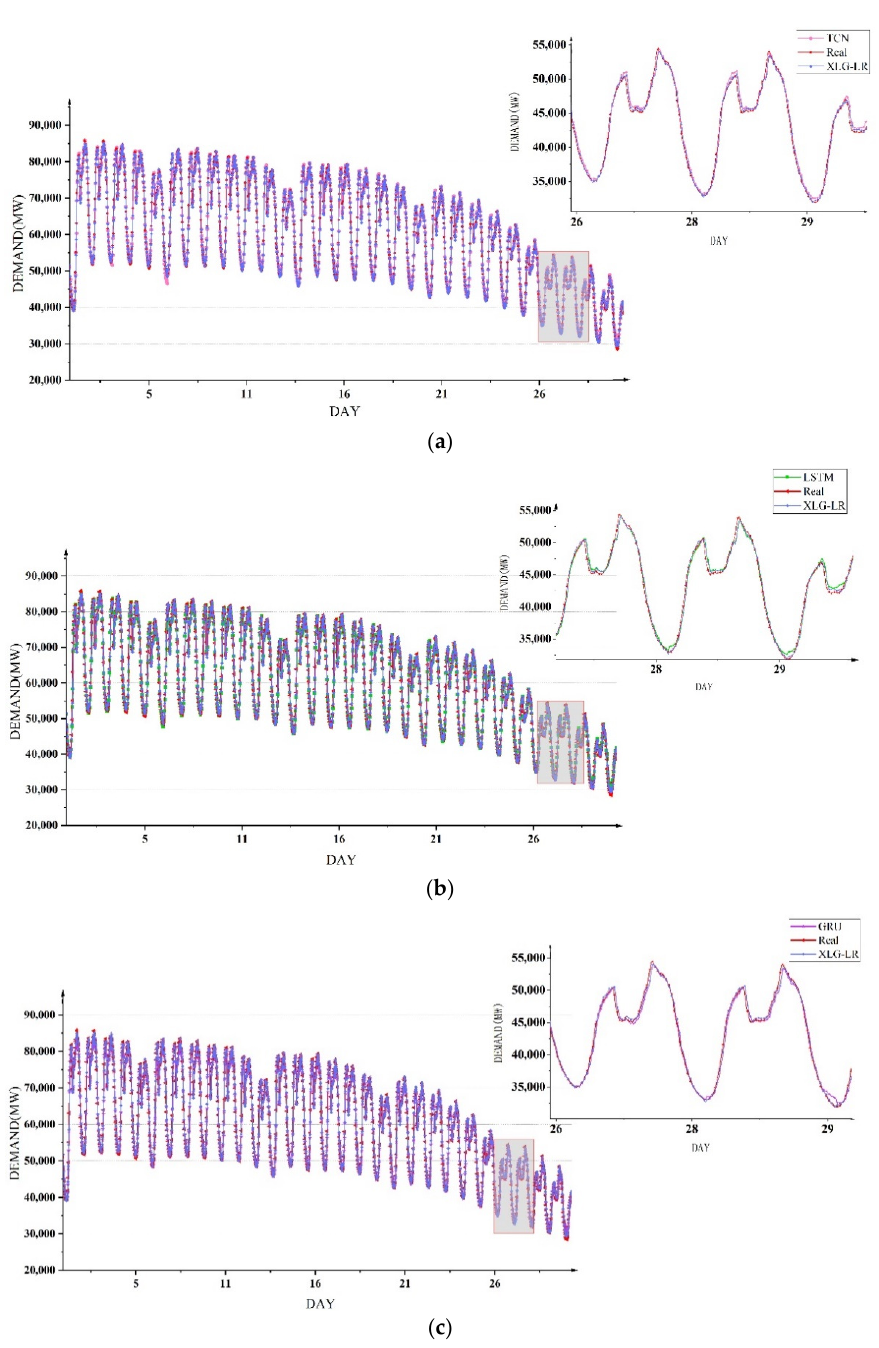
Figure 12. Comparison of Power Demand Forecasting of Different Models on a Monthly Basis. ( a ) TCN model; ( b ) LSTM model; ( c ) GRU model.